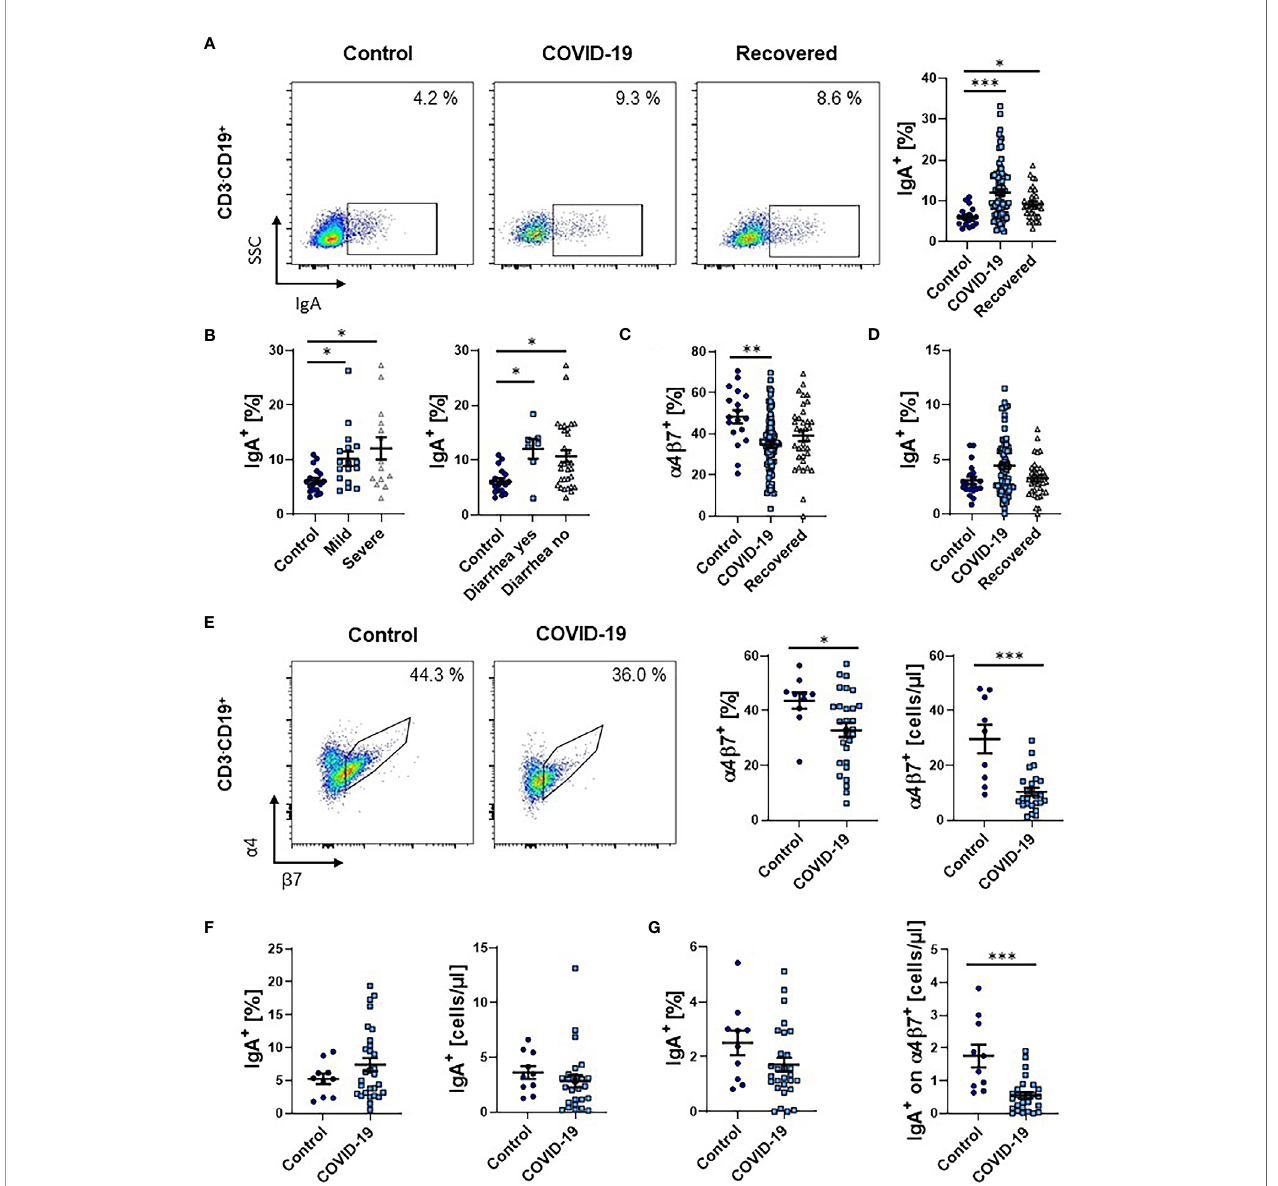
FIGURE 5 | Frequency of IgA + B cells during COVID-19. (A) Representative (left) and quantitative (right) fl ow cytometry of the frequency of IgA expressing CD3 - CD19 + B cells from PBMCs. (B) Quantitative fl ow cytometry of the frequency of IgA-expressing CD3 - CD19 + B cells in COVID-19 patients with mild or severe disease course (left) and with or without diarrhea (right) compared to healthy controls. (C) Quantitative fl ow cytometry of the frequency of a 4 b 7 integrin-expressing CD3 - CD19 + B cells. (D) Quantitative fl ow cytometry of the frequency of IgA + cells among CD3 - CD19 + a 4 + b 7 + B cells expressed as frequency of CD3 - CD19 + B cells. (E – G) Flow cytometry of whole blood samples from COVID-19 patients and healthy controls. (E) Representative (left) and quantitative (right) fl ow cytometry of the frequency and absolute cell numbers of a 4 b 7 integrin-expressing CD3 - CD19 + B cells. (F) Quantitative fl ow cytometry of the frequency (left) and absolute cell numbers (right) of IgA-expressing CD3 - CD19 + B cells. (G) Quantitative fl ow cytometry of the frequency (left) and absolute cell numbers (right) of IgA + cells among CD3 - CD19 + a 4 + b 7 + B cells expressed as frequency of CD3 - CD19 + B cells. Each symbol represents an individual subject, n = 7 - 80 per group. *p < 0.05, **p < 0.01, ***p <